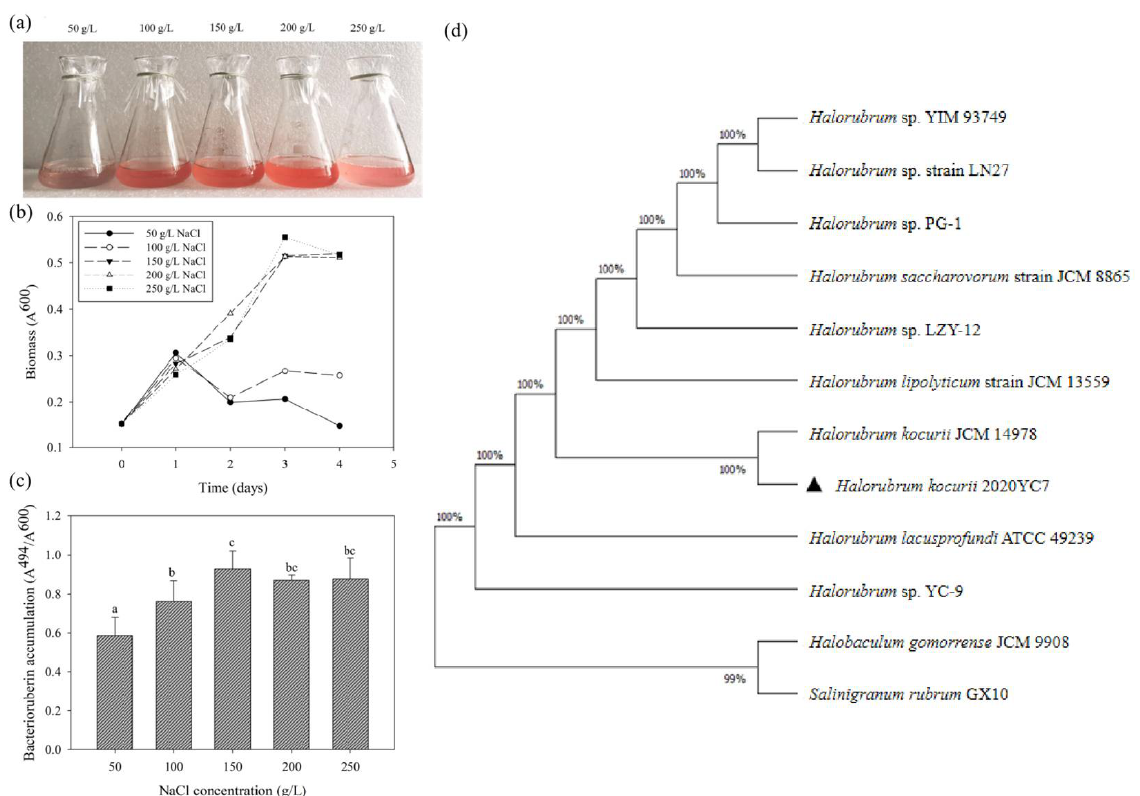
Figure 1. Growth status after 48 h incubation ( a ) in YCM2 medium, growth curve ( b ) and bacterio- ruberin accumulation ( c ) in YCM1 medium of H. kocurii 2020YC7 at 50, 100, 150, 200, 250 g/L NaCl concentration. Maximum likelihood (ML) algorithm method phylogenetic tree ( d ), based on 16s rRNA gene sequence of H.kocurii 2020YC7 (“ ▲ ” marked), and compared with Halorubrum sp. YIM 93749 (JF449434) Halorubrum sp. strain LN27 (MN829451), Halorubrum sp. PG-1 (KJ644278), Halo-